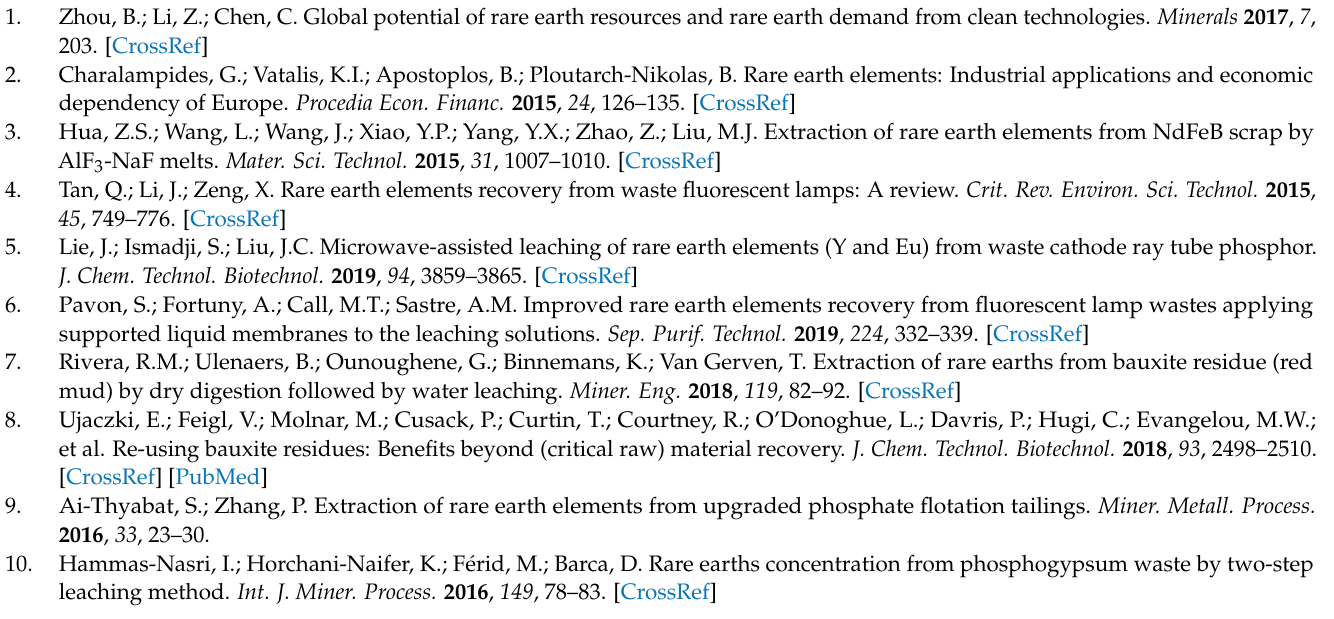
Table S14 : Semi-quantitative EDX analysis of mesoporous composite functionalized sorbent after loading with equimolar Nd, Gd, Sc, Ca and Mg solution and after treatment with polymetallic solution; Table S15 : SEM microphotographs of mesoporous composite functionalized sorbent after 5 cycles of sorption and desorption; Table S16 : Semi-quantitative EDX analysis of REEs ore, and after sorption/elution/oxalic acid